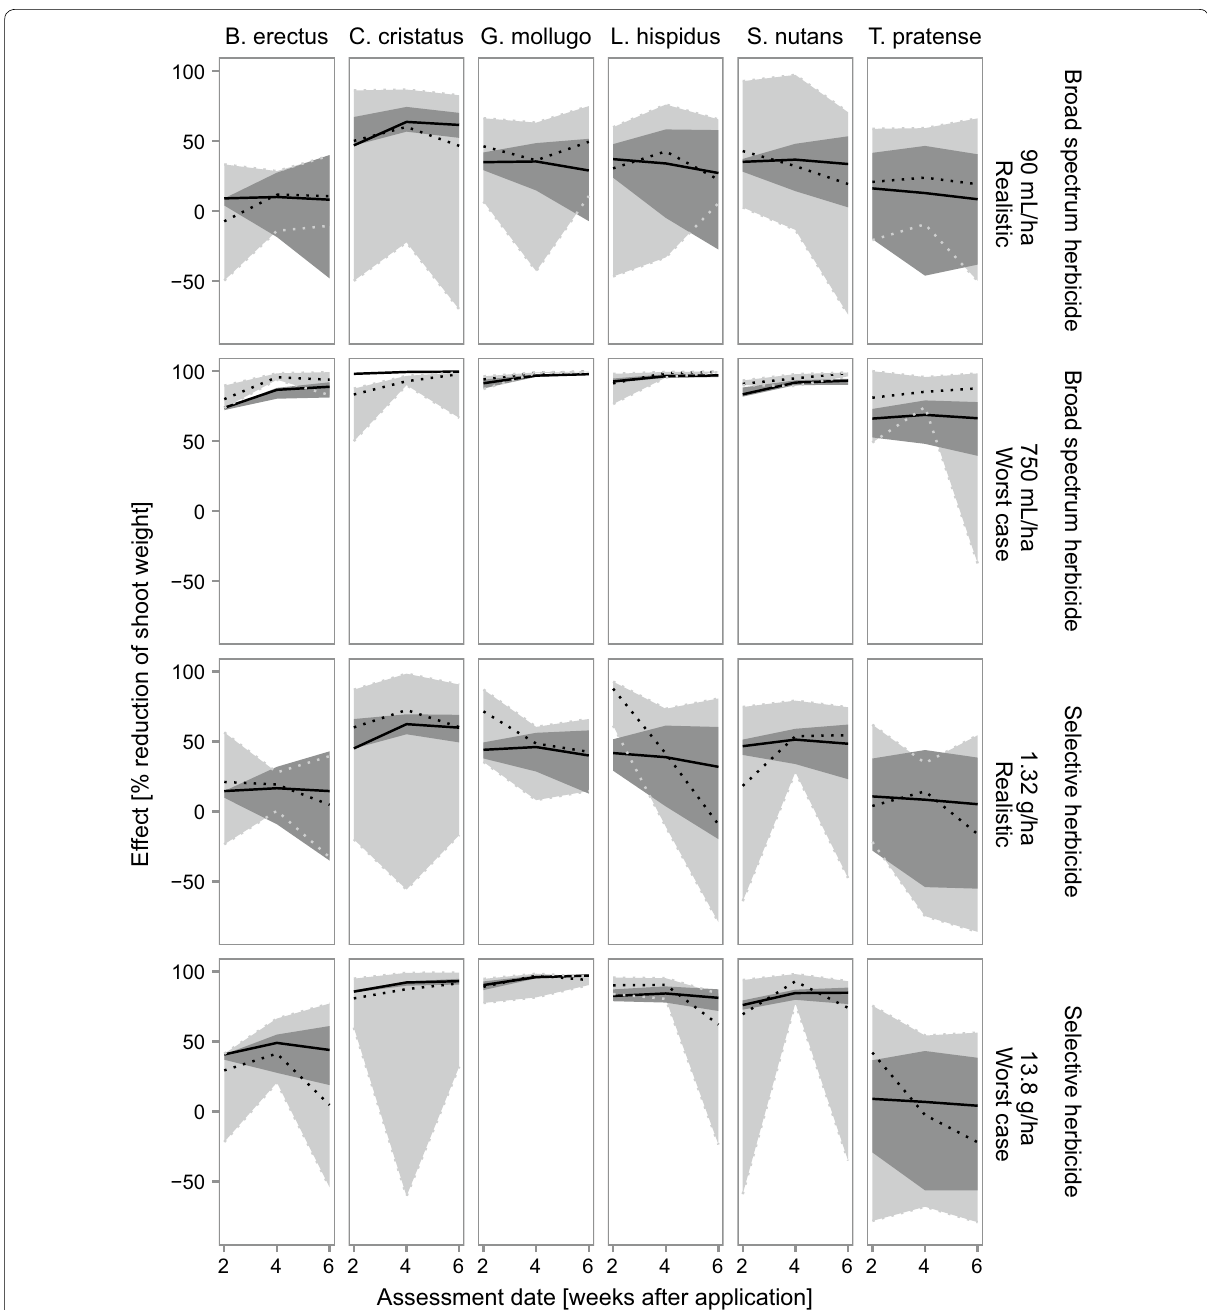
Fig. 5 Effects on species specific shoot masses (treatment/control) in the monocultures after herbicide application. Black solid lines represent the median of the model predictions and dark gray ribbons show the upper and lower 2.5th percentile of the predictions. Dotted black lines show the empirically measured median and gray ribbons and dotted gray lines the upper and lower 2.5th percentile of these. Only the lowest (realistic) and highest (worst-case) tested application rates are presented here. The lowest rates tested were in the same range (broad spectrum herbicide Roundup) or higher (selective herbicide Monitor) than the rates that would be applicable to the risk assessment considering European standard drift rates. The results for these test rates are presented to deliver a more realistic picture. Results for the whole range of tested application rates can be found in Additional file 1: Appendix